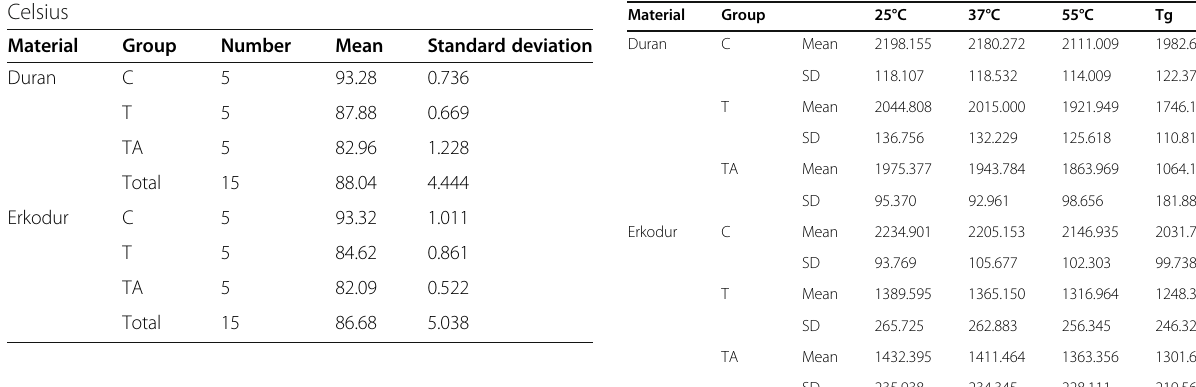
Table 5 Descriptive analysis of E ′ at different temperatures